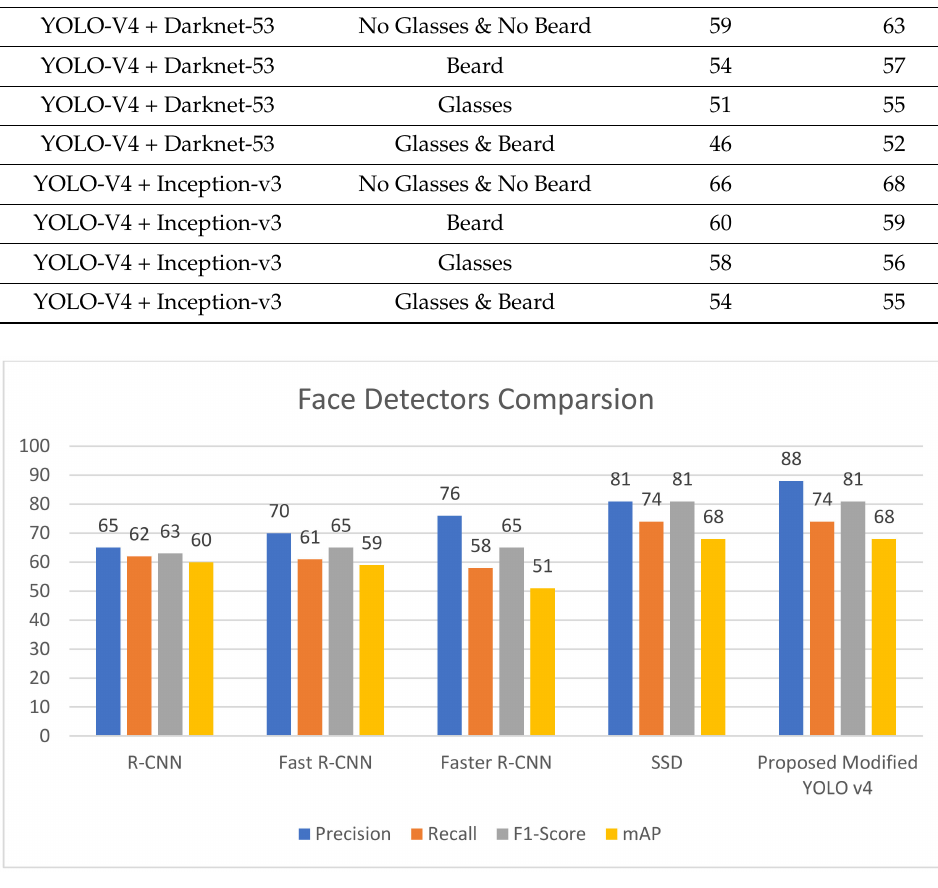
Figure 10. Performance comparison of various object detection techniques for face detection.